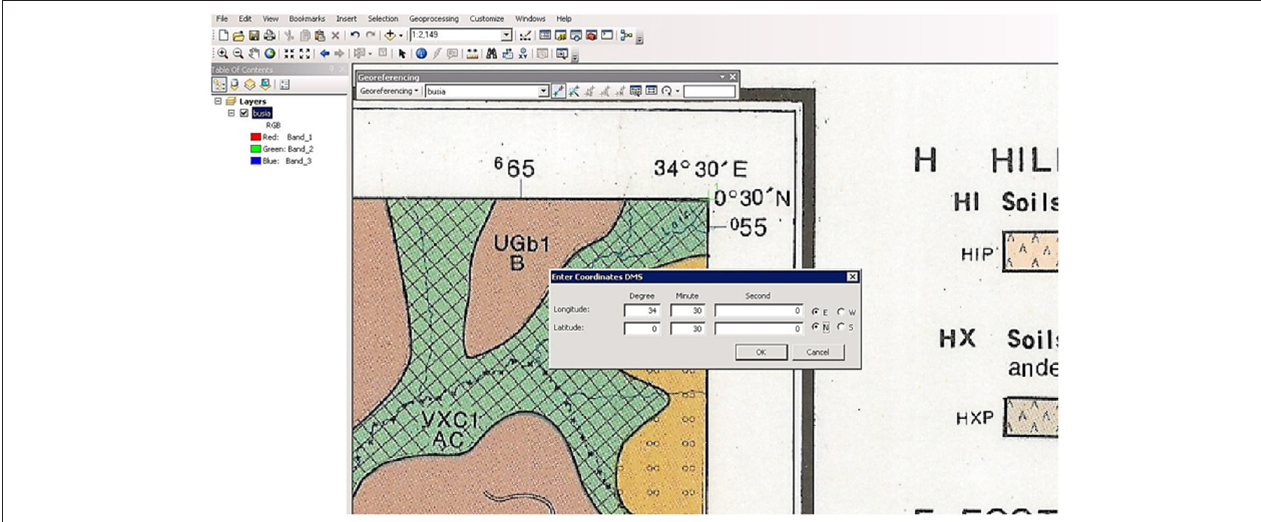
FIGURE 5 | Geo-referencing of the reconnaissance soil map of the Busia area map using the top right corner geodetic control point. This geodetic control point is designated 34 ◦ 30 ′ E, 0 ◦ 30 ′ N.